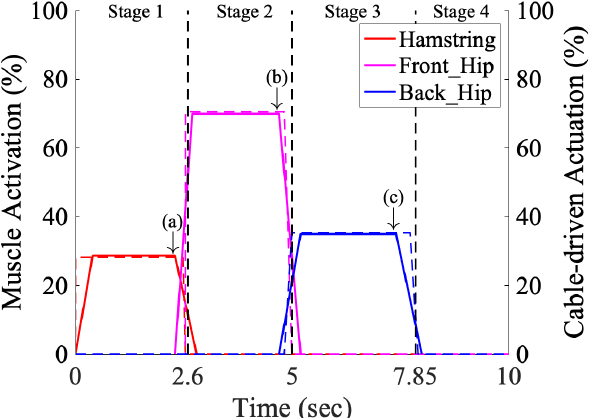
Figure 5. The applied activations by the three virtual “muscles” in the OpenSim 3.0 simulation environment (full line), and the intensity from the cable-driven actuators on the prototype (dotted lines). The varying levels of actuation (i.e., applied forces) input into the simulated models generalize an approximation for how to actuate the muscle-inspired cables in the prototype. Labels (a–c) indicate where the applied contracting muscles